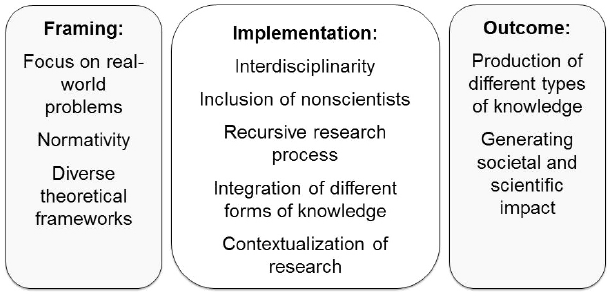
Fig. 1. Characteristics of transdisciplinary